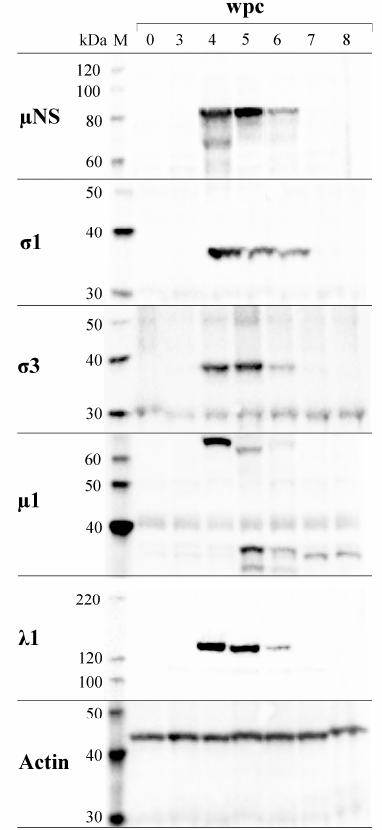
Figure 6. Presence of PRV proteins in blood cells. Pooled blood cell samples ( n = 6) from each week were analyzed by Western blotting, targeting μ NS, σ 1, σ 3, μ 1 and λ 1. M = molecular weight standard. Actin was used as control for protein load.